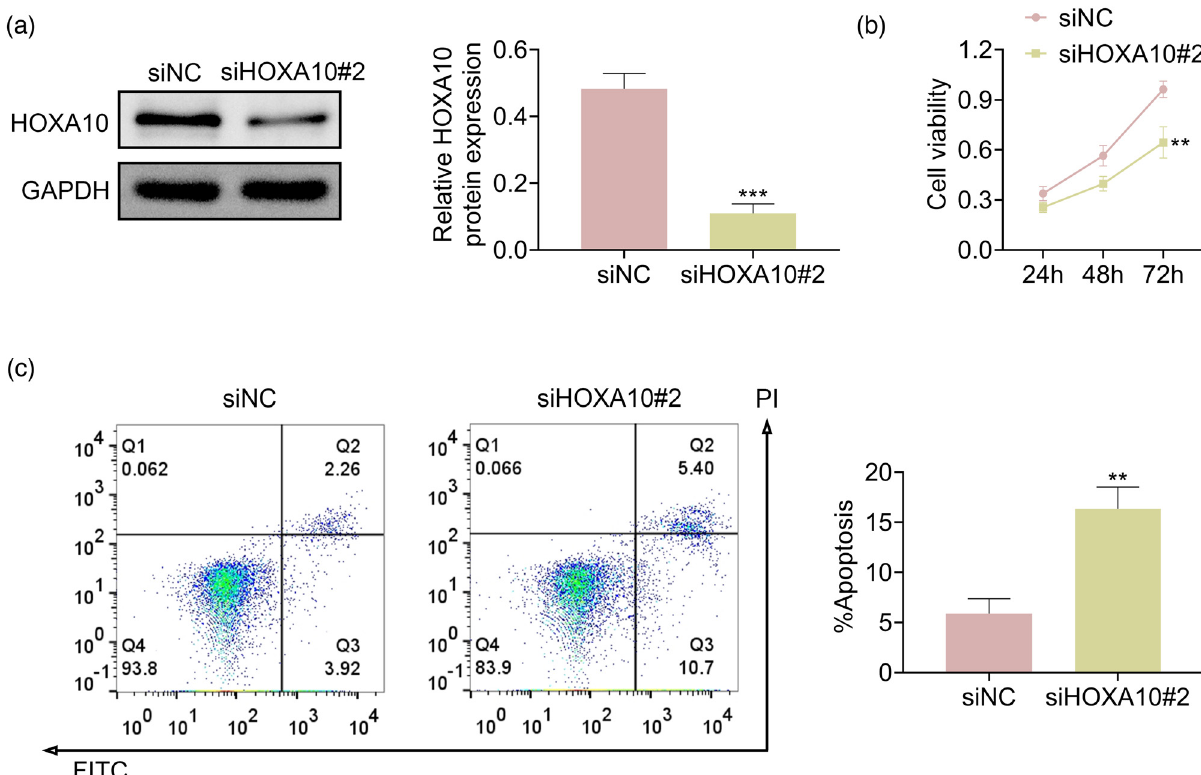
Figure A1: Knockdown of HOXA10 reduced cell proliferation and enhanced apoptosis in EC cells. ( a ) The western blot showed HOXA10 expression in Eca - 109 cells. ( b ) The cell viability in Eca - 109 cells was determined by CCK - 8 assay. ( c ) The cell apoptosis in Eca - 109 cells was detected by Annexin V - FITC